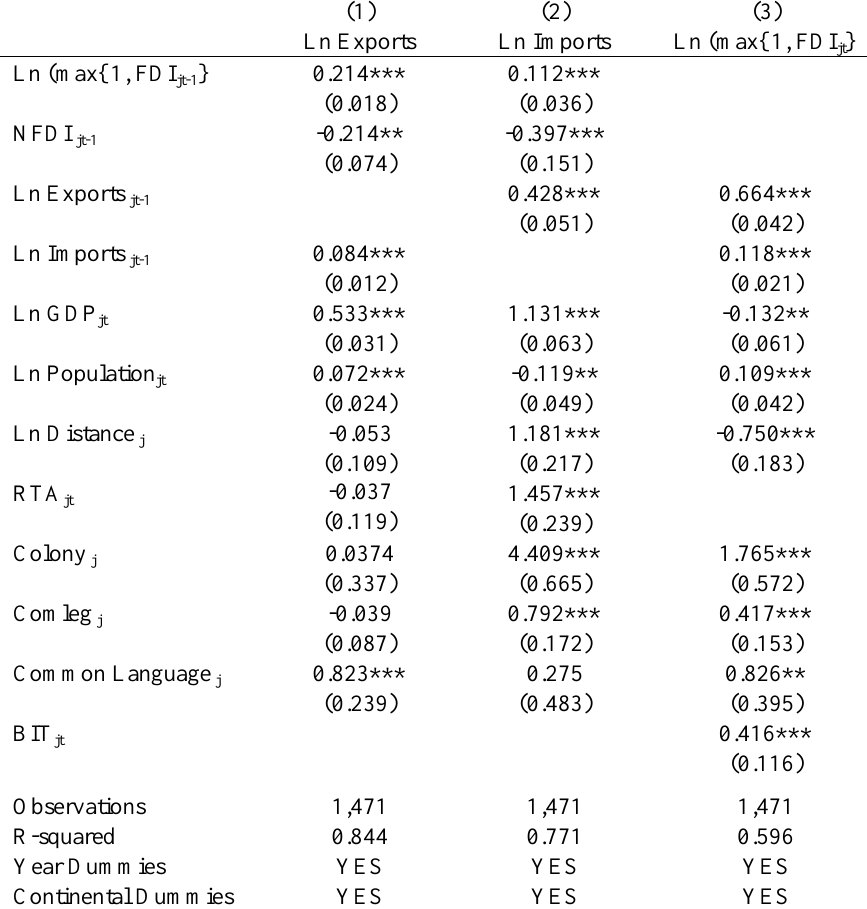
Table 2 . Results with Seemingly Unrelated Regressions